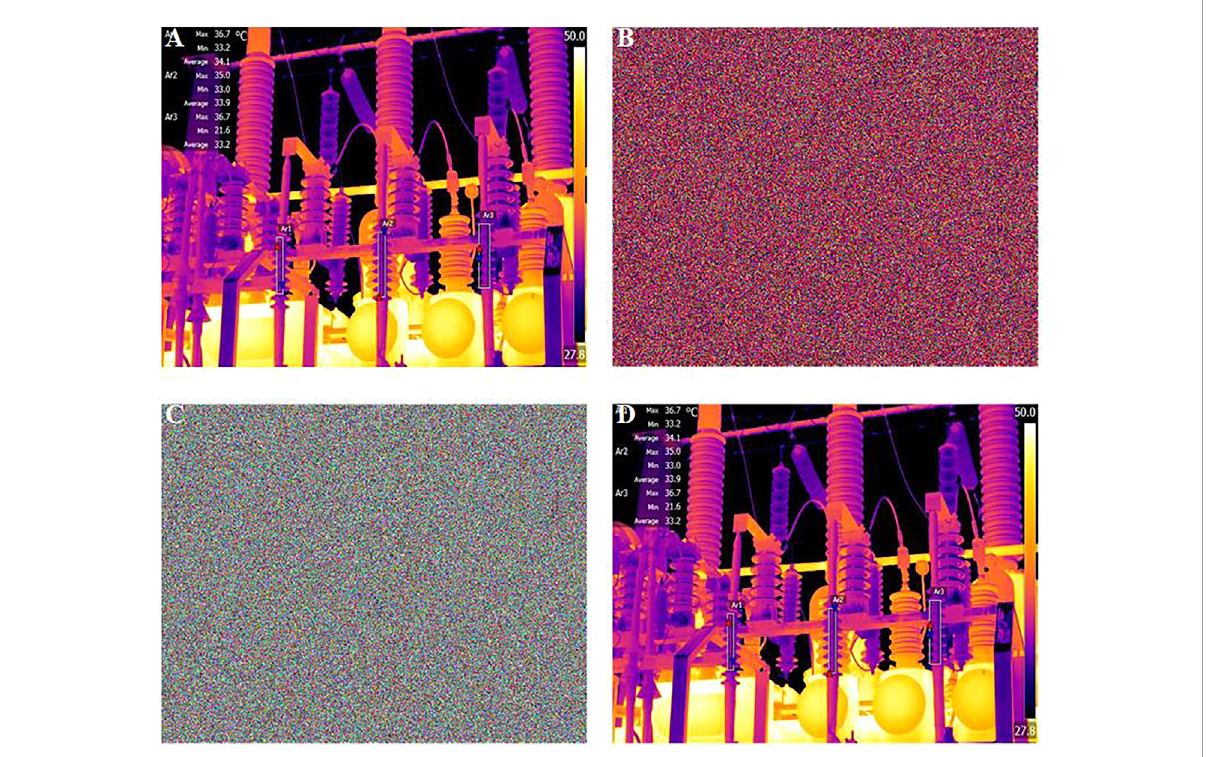
FIGURE 11 The diagram of experimental results, (A) Electronic equipment Picture 2 (B) Scrambled Picture 2 (C) Encrypted Picture 2 (D) Decrypted Picture 2.